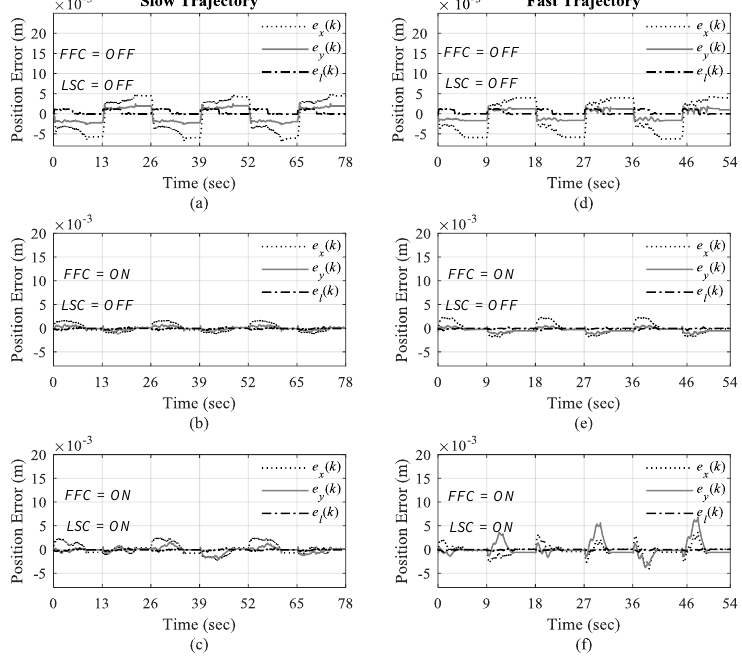
Figure 13. Trajectory tracking error for slow trajectory in ( a ) 1st; ( b ) 2nd; ( c ) 3rd scenarios, and for fast trajectory in ( d ) 1st, ( e ) 2nd; and ( f ) 3rd Scenarios.